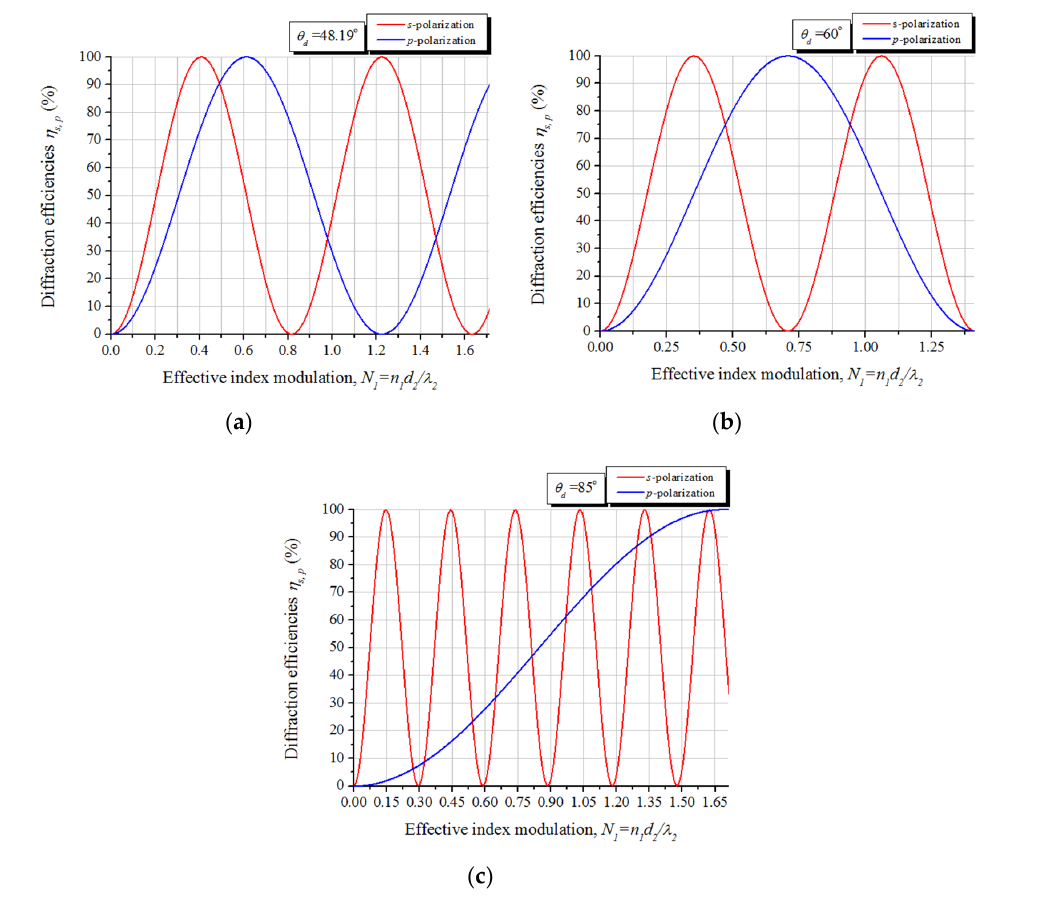
Figure 2. Di ff raction e ffi ciencies versus e ff ective index modulation at ( a ) θ d = 48.19 ◦ ; ( b ) θ d = 60 ◦ ; ( c ) θ d = 85 ◦